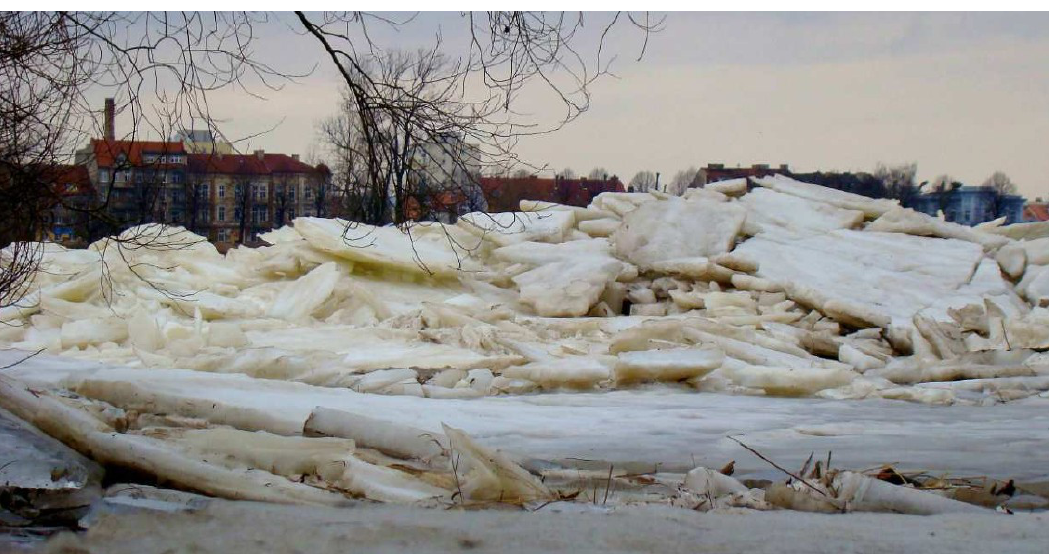
Figure 2. Ice jam on the Oder River at Frankfurt/Oder on 24 February 2012 (photo by Halka Beberstedt; used with permission).